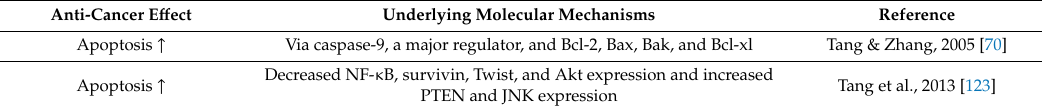
Table 4. In vitro molecular mechanism of the anti-cancer e ff ects of phenethyl isothiocyanate. Anti-Cancer E ff